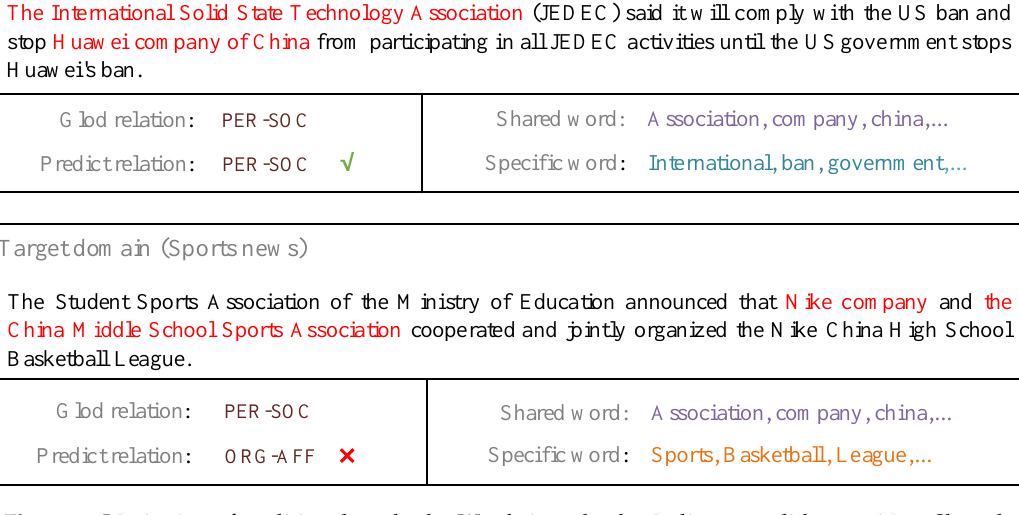
Figure 1. Limitation of traditional methods. Words in red color indicate candidate entities. Shared word indicates the words both appeared in the source domain and target domain. Specific word indicates the words only appeared in the source/target